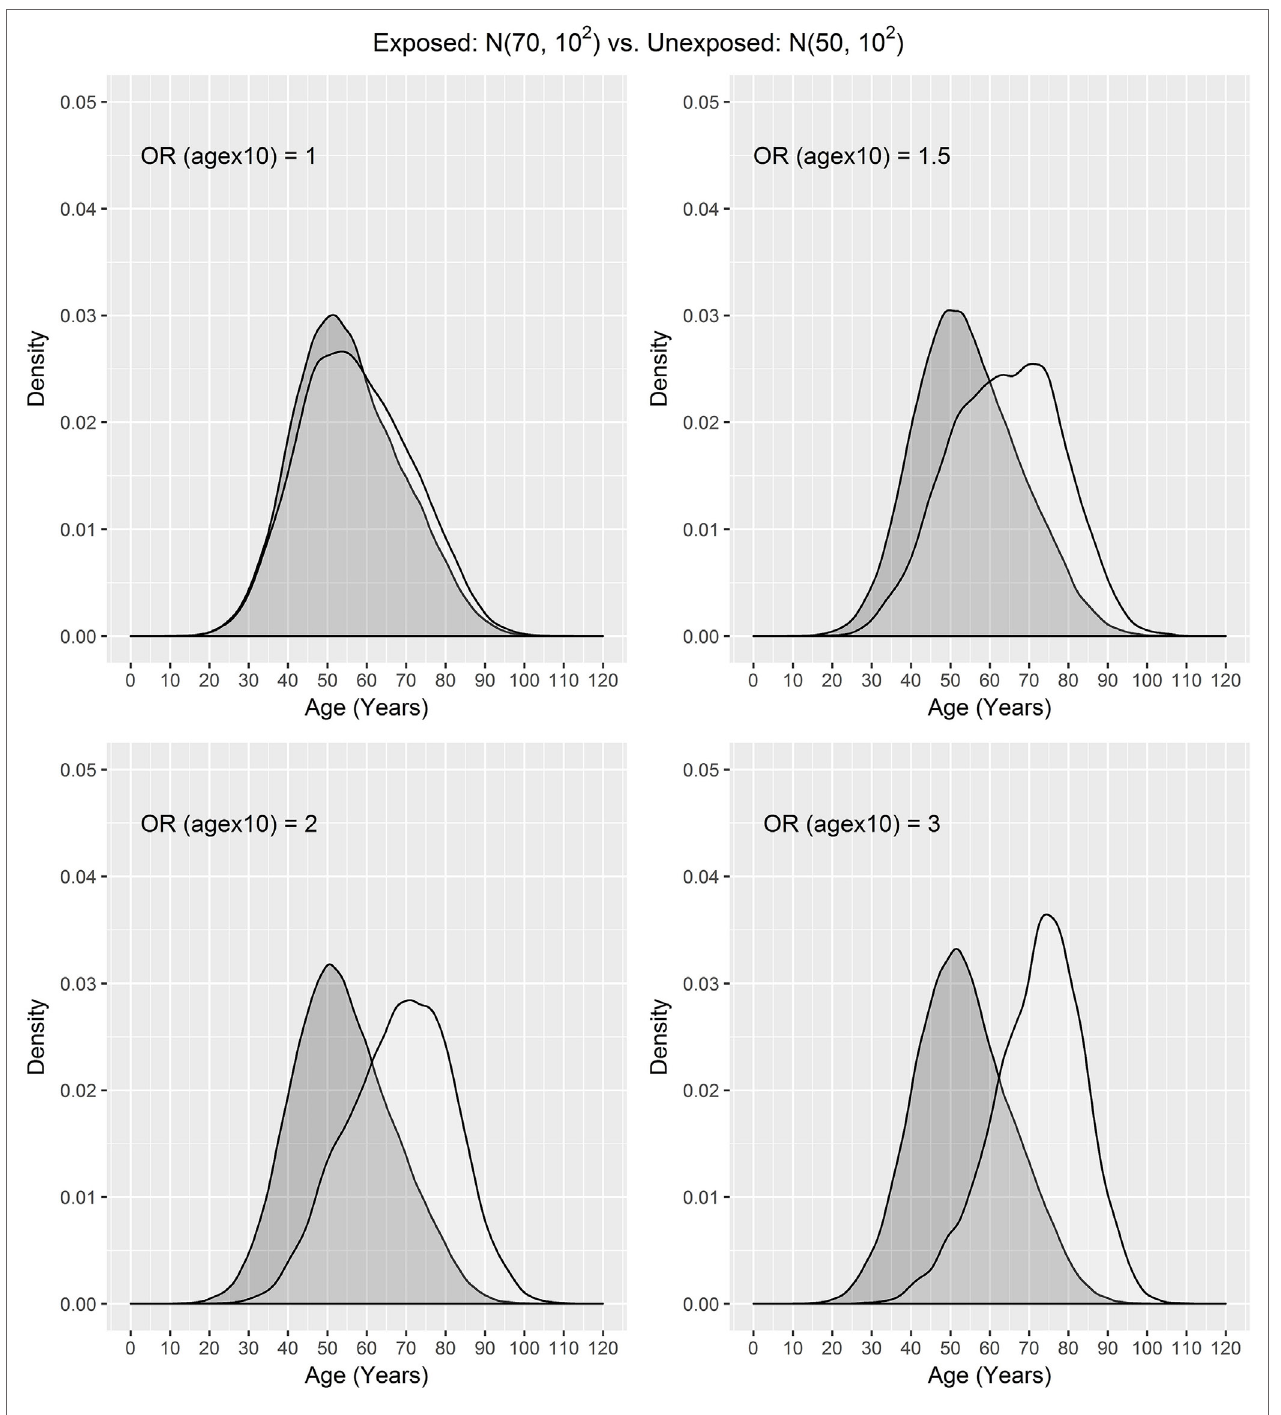
FigUre 2 | Age distributions of cases (white) and controls (grey) in the population where the age distributions of exposed and unexposed subjects are N (70, 10 2 ) and N (50, 10 2 ) and OR (agex10) denotes odds ratio associated with a 10-year increase in age.